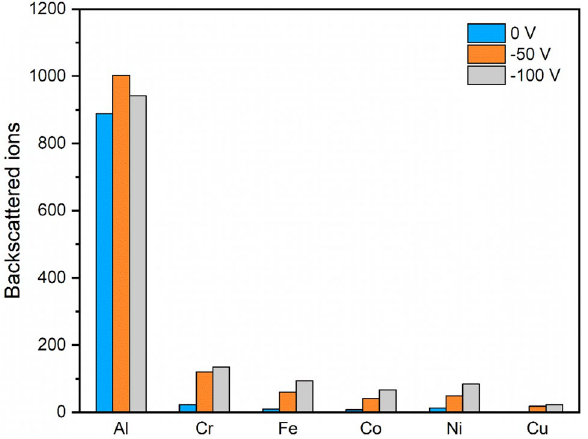
Figure 1. Backscattered ions per 10,000 ions deposited for each element with substrate bias of 0 V, −50 V, and −100 V.